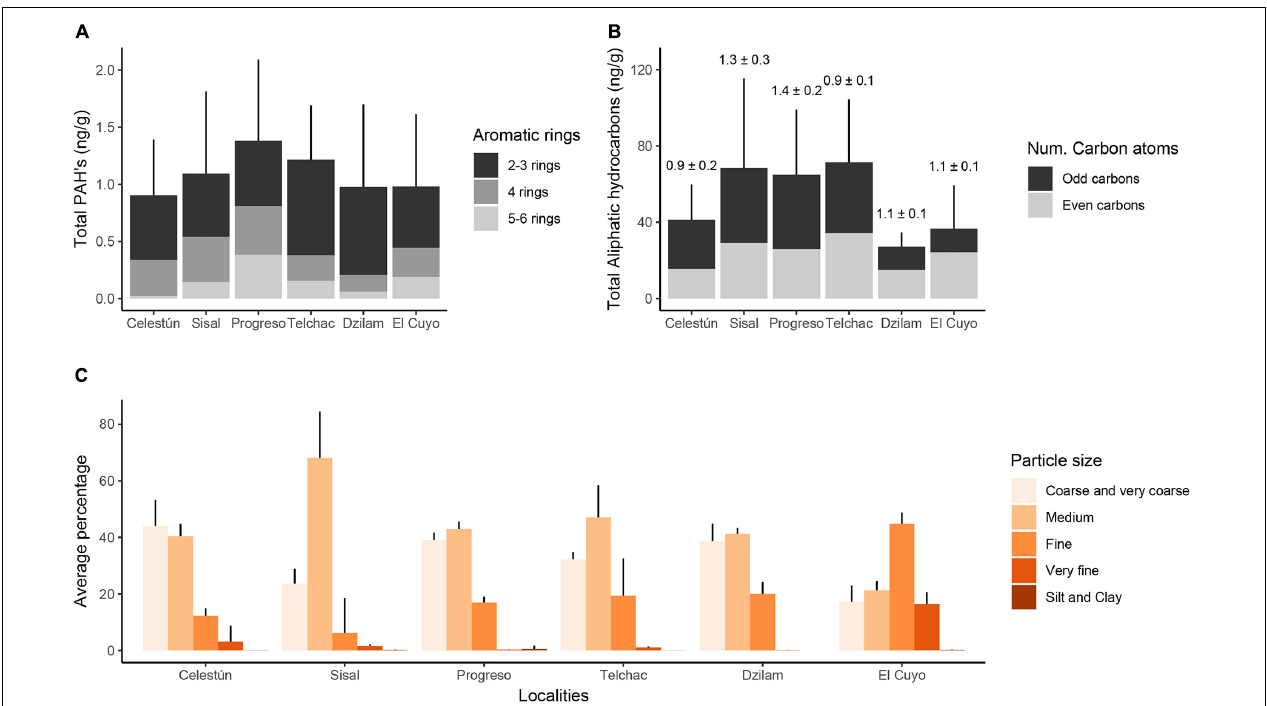
FIGURE 6 | Analyses of sediments on the beaches of the state of Yucatán. (A) Average and standard deviation of the Total of PAHs and their respective fractions according to the number of rings. (B) Average and standard deviation of the Total of Aliphatic Hydrocarbons, and their fractions according to the number of carbon atoms. The CPI (mean ± sd) for each locality is showed over each column. (C) Average of the relative fractions of the grain size of the sediments.